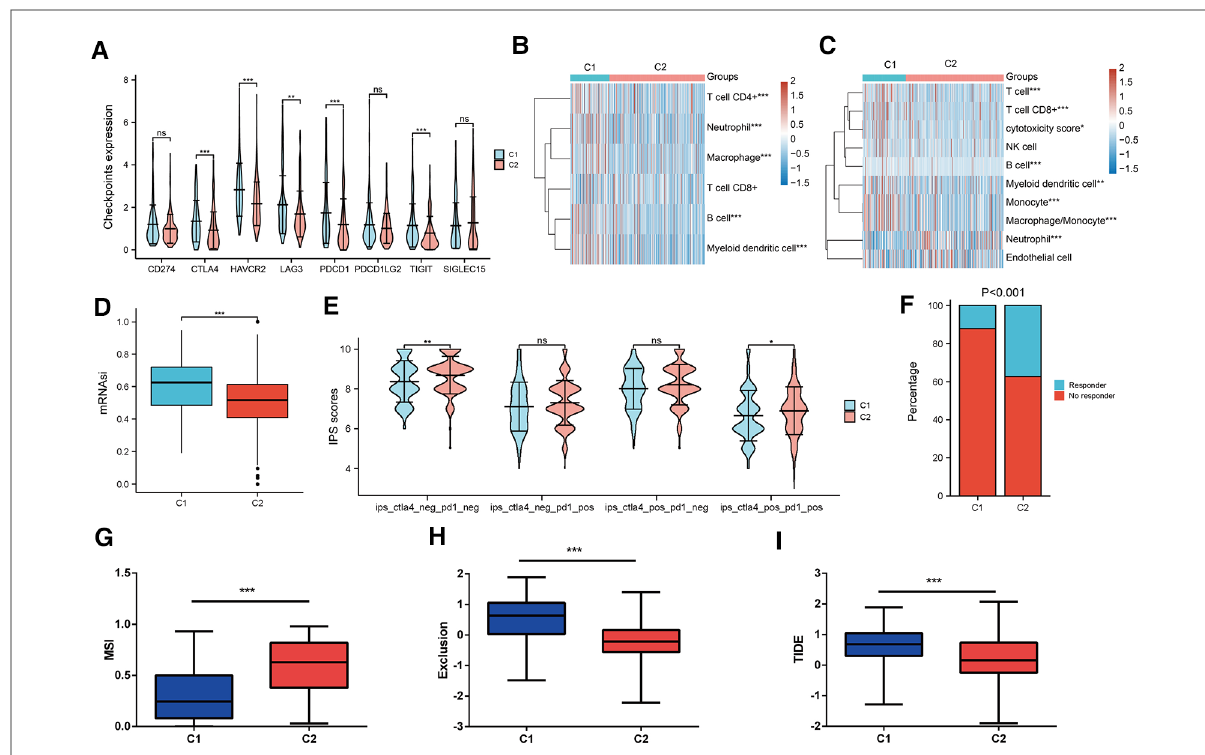
FIGURE 5 Prediction of TME and ICB response in two MRPs related subtypes. ( A ) Differential expression of immune checkpoints in two groups. ( B ) TIMER and ( C ) MCPCOUNTER algorithms estimated the levels of immune cell in fi ltration. ( D ) OCLR algorithm calculated the stemness scores in two clusters. ( E ) IPS predicted the anti-PD1 and anti-CTLA4 therapy response in two molecular subtypes. ( F ) TIDE algorithm assessed the percentage of responders. ( G ) MSI, ( H ) Exclusion scores, ( I ) TIDE scores across two